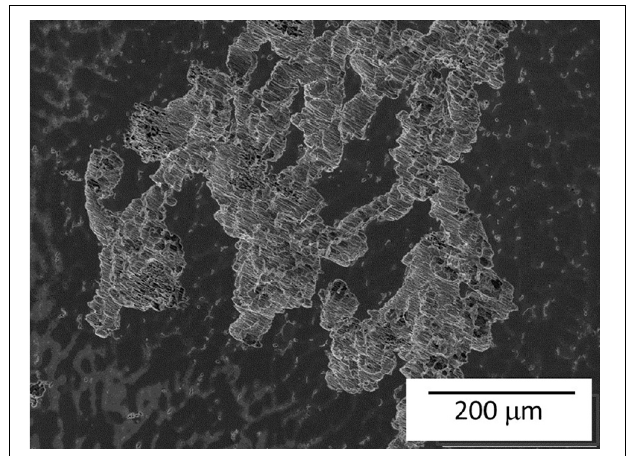
FIGURE 11 | SEM micrograph of severe localized corrosion of as-cast Mg-10Gd alloy after 5 h exposure in 0.5 wt.% NaCl